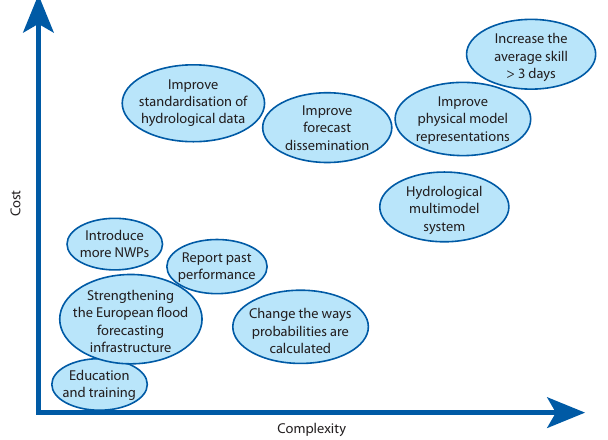
Fig. 1. Schematic view of the relative cost and difficulty of the top 10 priorities from the